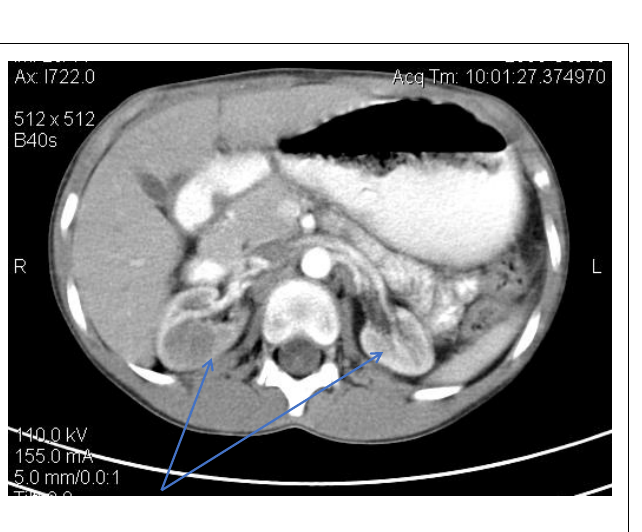
Figure 2. Abdominal CT scan—expansive renal formations replacing renal parenchyma and with a mass effect (blue arrow).